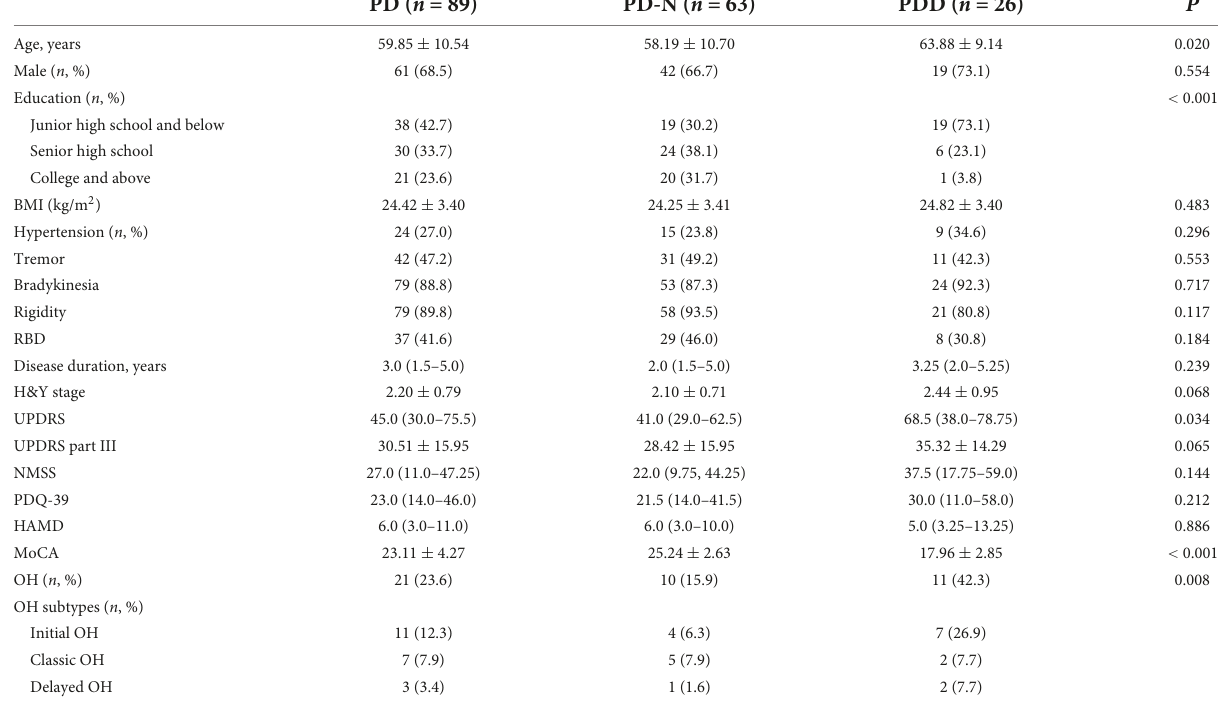
TABLE 2 Detailed demographic and clinical information of PD patients.